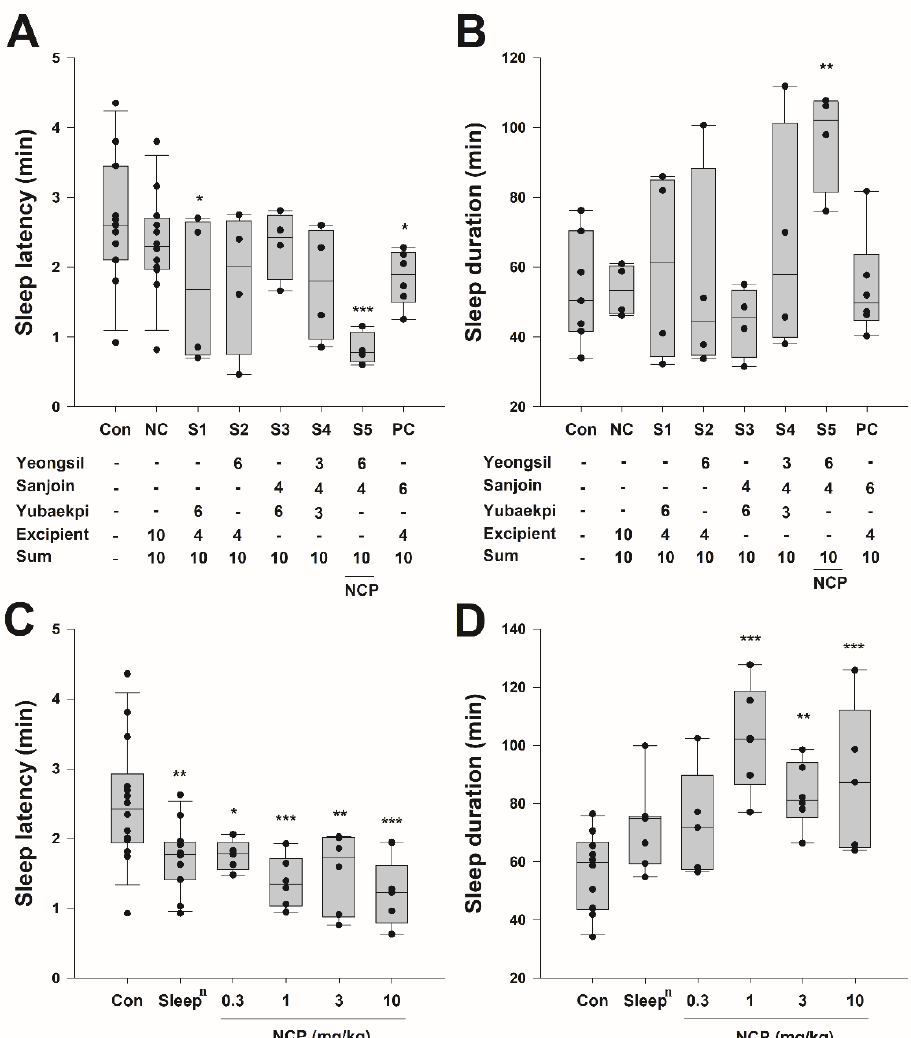
Figure 3. Optimal natural product combination screening. Changes in sleep latency ( A ) and sleep duration ( B ) in mice when different combinations were ingested. Sleep latency ( C ) and sleep duration ( D ) of mice fed NCP by concentration. All data were verified for significance through one-way ANOVA and post-test by Fisher-LSD method to obtain significance between groups. The control group is saline of the same volume. *** p < 0.001, ** p < 0.01, * p < 0.05.